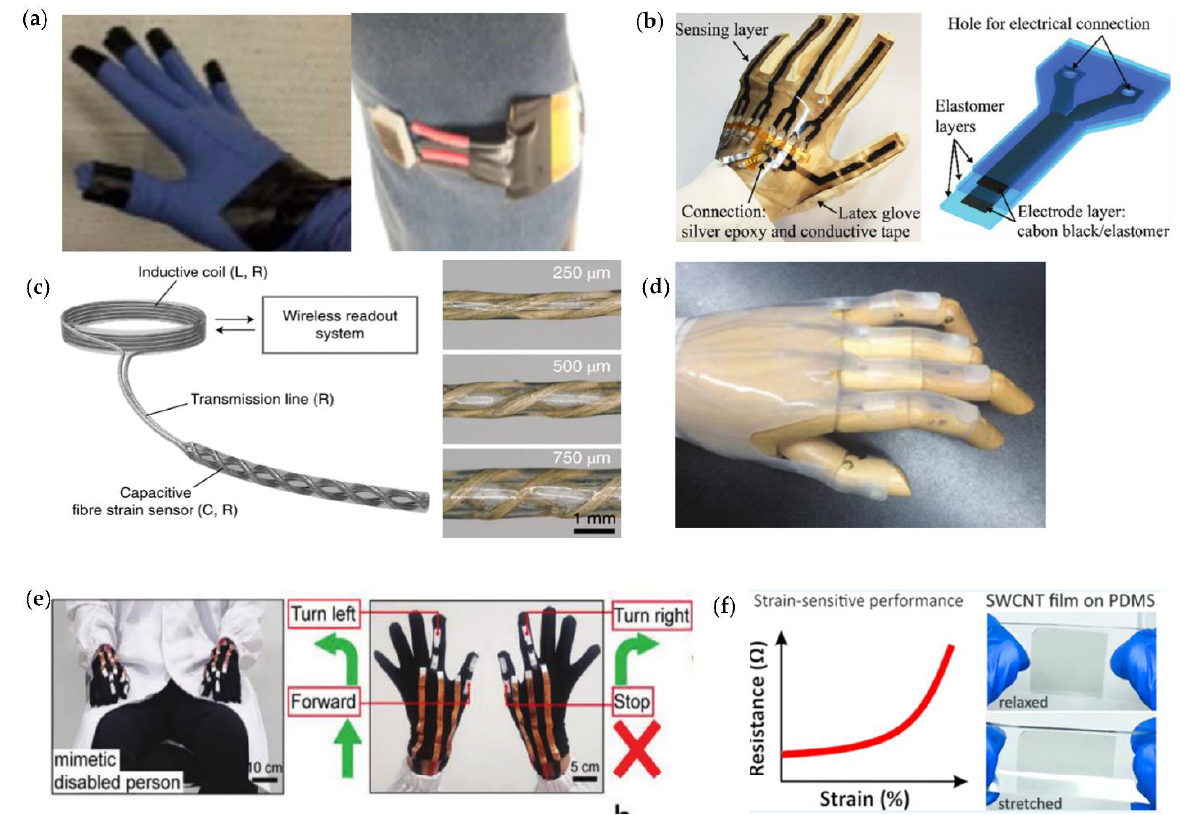
Figure 9. Representative of flexible strain sensors with conventional polymer substrate. ( a ) CNT-fibers-based strain sensor for monitoring human motion (Reprinted with permission from ref. [103]. Copyright 2015 American Chemical Society); ( b ) An intelligent glove (left) integrating five independently operated sensors, the sensor structure (right) consists of electrode layers and dielectric layers (Reprinted with permission from ref. [91]. Copyright 2017 WILEY ‐ VCH Verlag GmbH & Co. KGaA, Weinheim); ( c ) A fiber strain sensor for wireless strain-sensing system (left), fiber strain sensors with various hollow-core diameters (right) (Reprinted with permission from ref. [102]. Copyright 2021 The Authors); ( d ) A glove soft sensor on a hand mock-up (Reprinted with permission from ref. [107]. Copyright 2018 Mary Ann Liebert Inc); ( e ) Smart gloves with the strain sensors attached on the finger for wireless human – machine manipulation (Reprinted with permission from ref. [10]. Copyright 2021 WILEY ‐ VCH GmbH); ( f ) Mechanically tunable strain sensor based on SWCNT/PDMS (Reprinted with permission from ref. [104]. Copyright 2019 American Chemical Society).